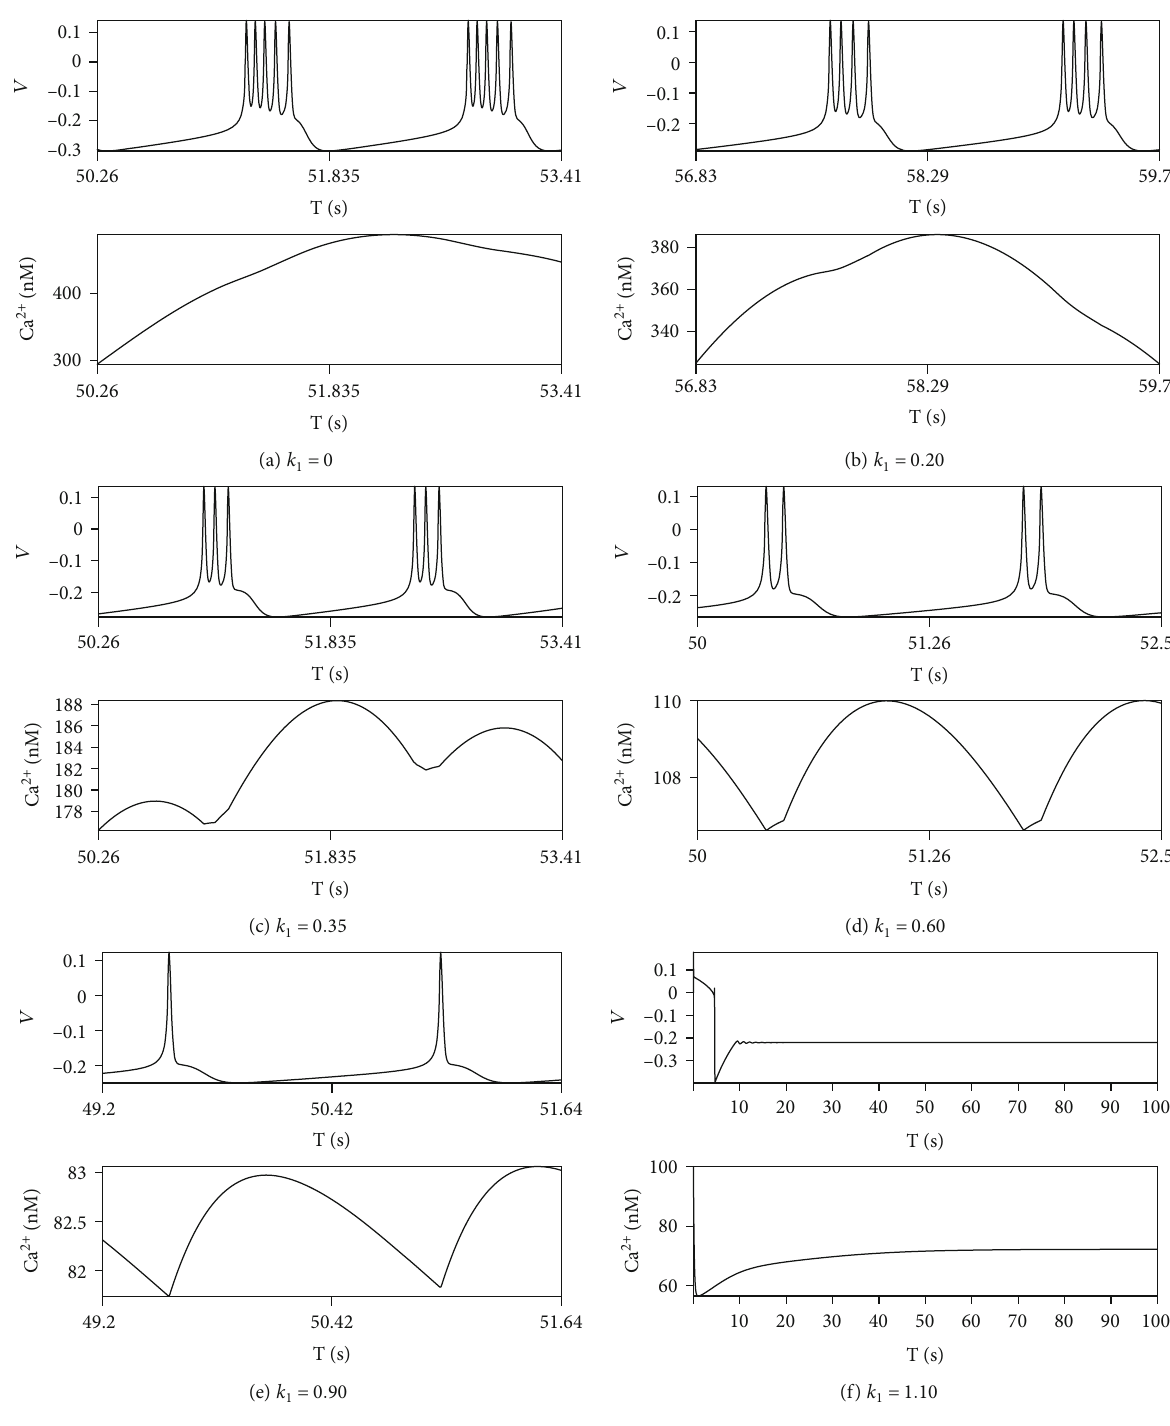
Figure 7: The neuron fi ring modes and Ca 2+ activities as r = 80mMs ‐ 1 IP 3 is greater than 1 dominates the fi ring mode as k There is no mixing mode when r = 80mMs ‐ 1 , see 1 IP 3 (Figure 7(f)). Figure 7. Ca 2+ concentration oscillates either beyond the = 100mMs ‐ 1 , di ff erent neuron fi ring modes With r threshold (Figures 7(a) and 7(b)) or beneath the threshold IP 3 represent in Figure 8 as varying k . Mixing mode is observed (Figures 7(c) – 7(e)). Ca 2+ concentration does not oscillate 1 when k = 0 , but it suddenly vanishes when k is little bit around the threshold which guarantee that depolarization 1 1 more than 0. Mixing modes cannot be discovered only except blockage cannot be appear in fi ring modes. Resting fi ring